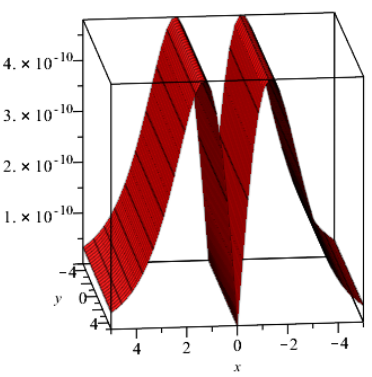
Figure 3. Behavior of the analytical solution at different values of β for problem 1.